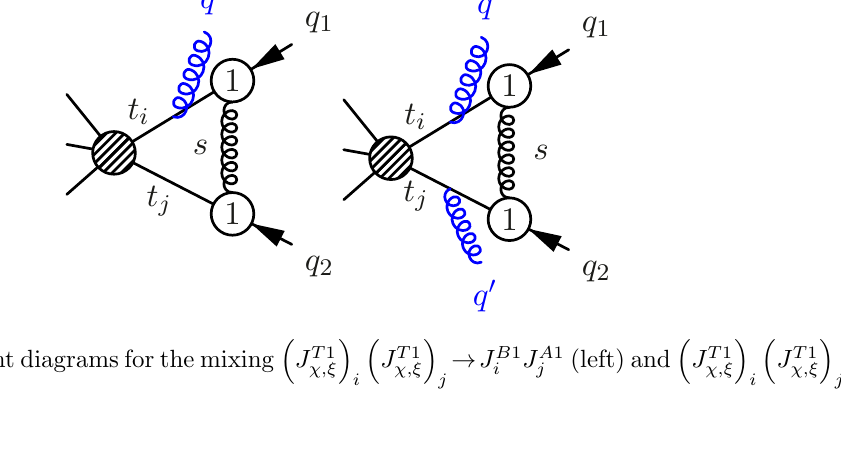
(cid:16) (cid:17) (cid:16) (cid:17) J T 1 J T 1 J B 1 J A 1 (left) and i j (cid:31);(cid:24) (cid:31);(cid:24) i j !